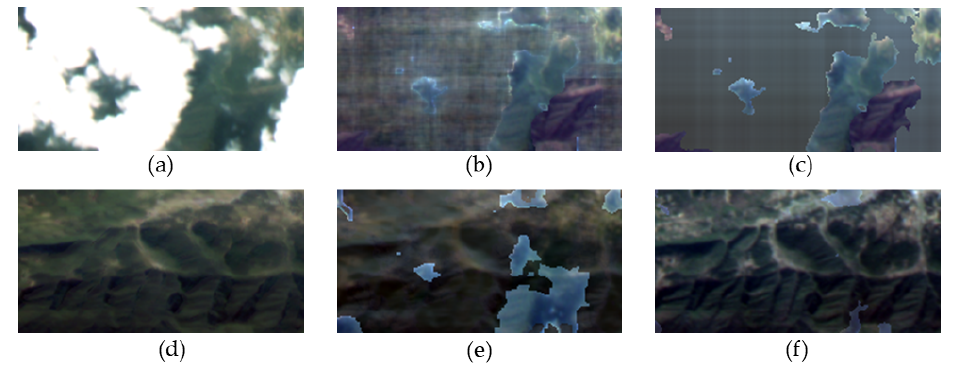
Figure 17. ( a – f ) Detailed regions clipped from Figure 16a–f. Table 5. The SD, FD, IE, BIQME, and PAQ-2-PiQ of the first real-data experimental results. The values of the highest accuracies are in bold.